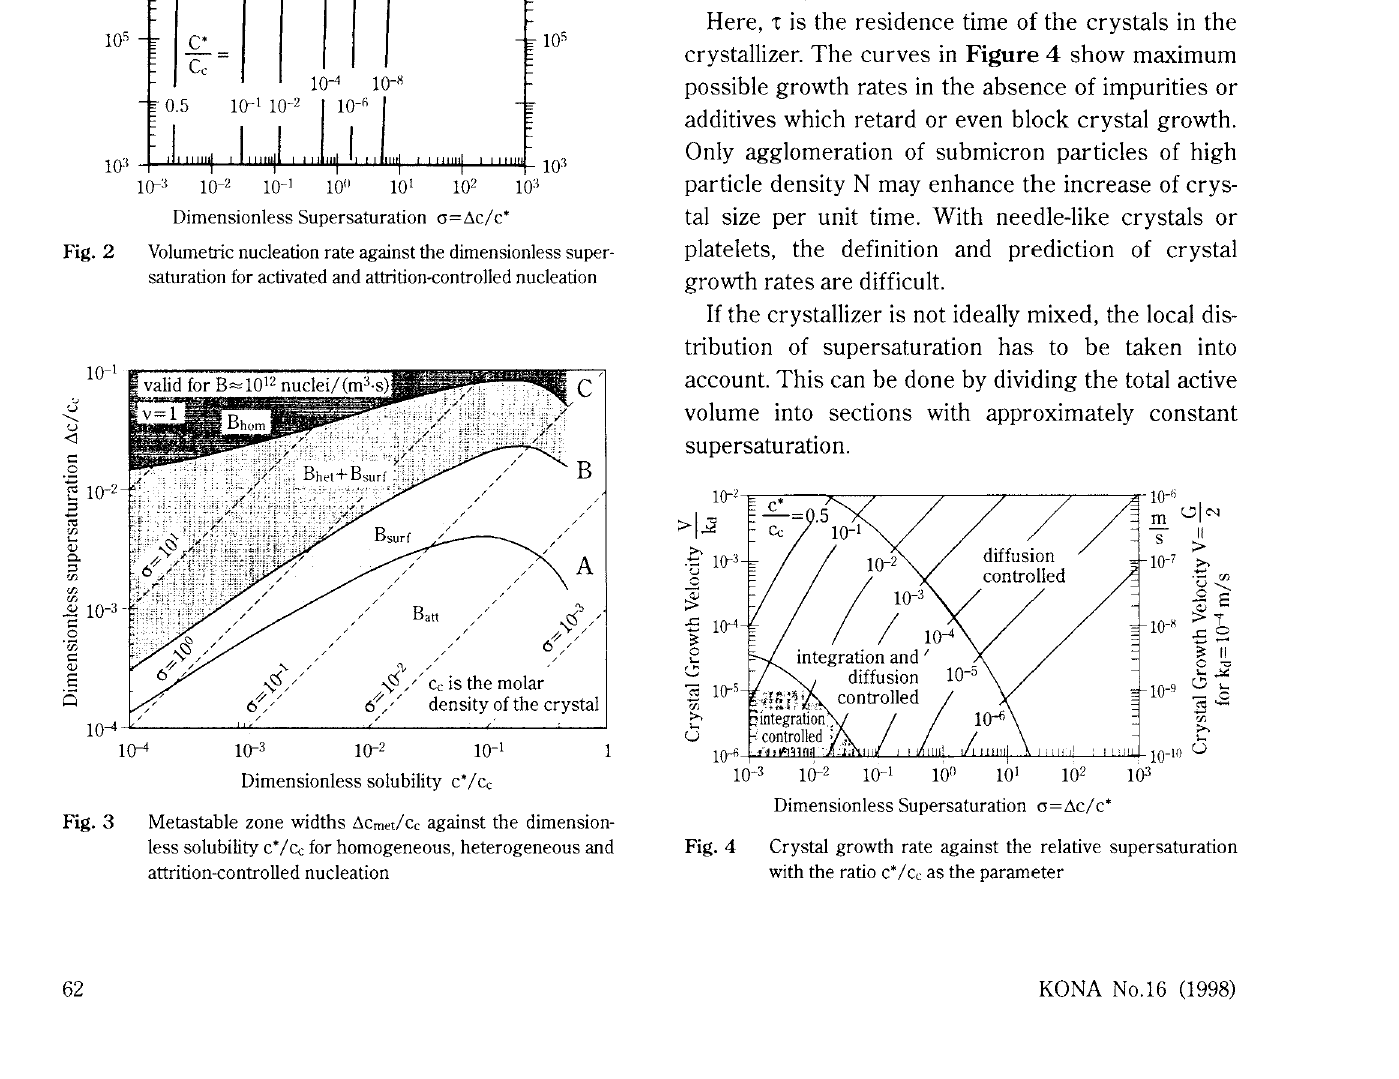
Metastable zone widths !J.CmetiCc against the dimension less solubility c' ICc for homogeneous, heterogeneous and attrition-controlled nucleation